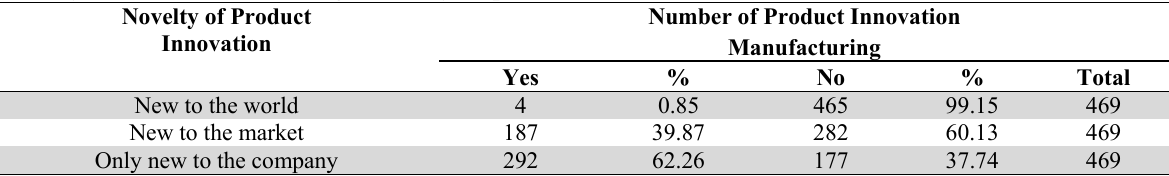
Novelty of New Product or Significantly Improved Products Based on Business Sectors Novelty of Product Number of Product Innovation Innovation Manufacturing Yes % No % Total New to the world 4 0.85 465 99.15 469 New to the market 187 39.87 282 60.13 469 Only new to the company 292 62.26 177 37.74 469 Source: NSI-7